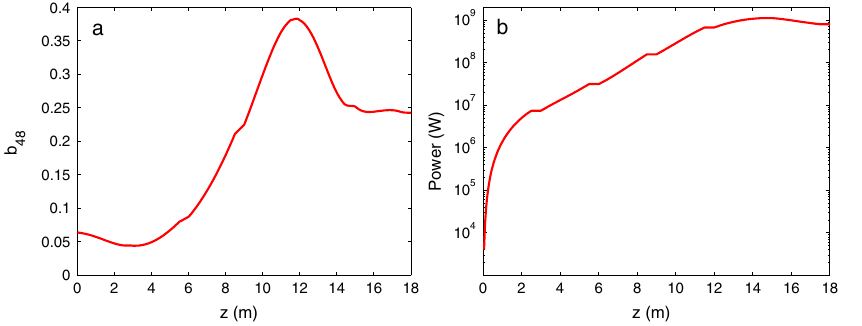
FIG. 12. (Color) (a) Bunching factor vs radiator distance for the 5 nm radiation. (b) Peak power vs radiator distance for the 5 nm